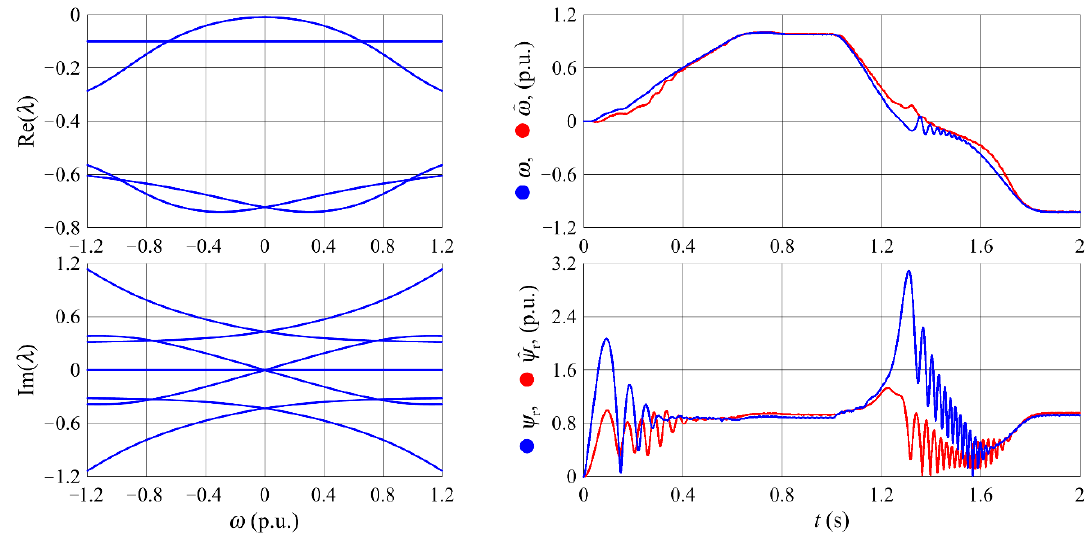
Figure 7. The eigenvalues and simulation results obtained for the PI observer.